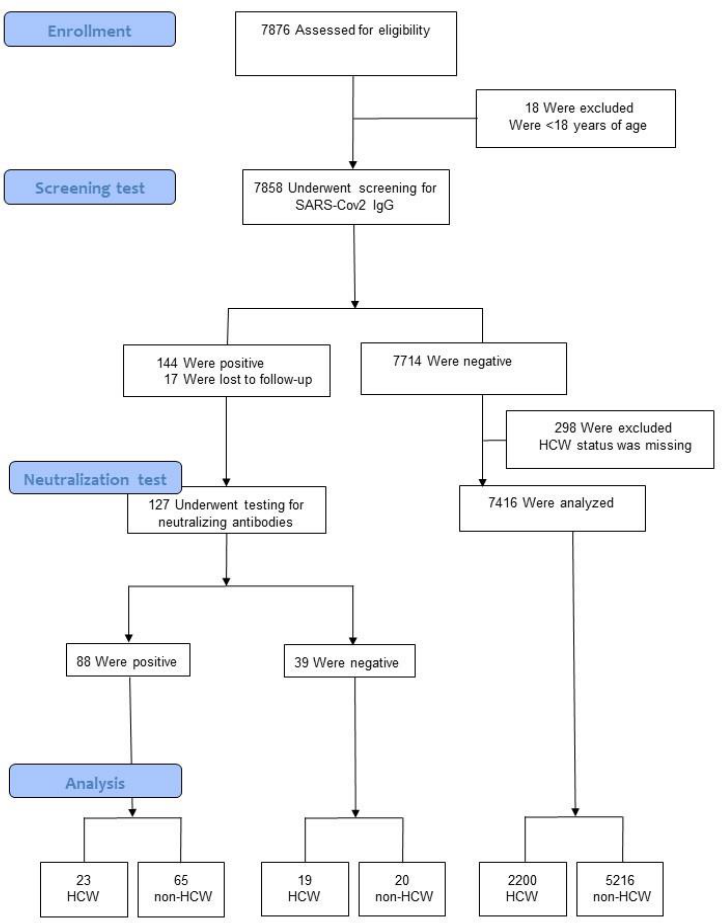
Figure 2. Flow diagram. Healthcare workers: HCW.